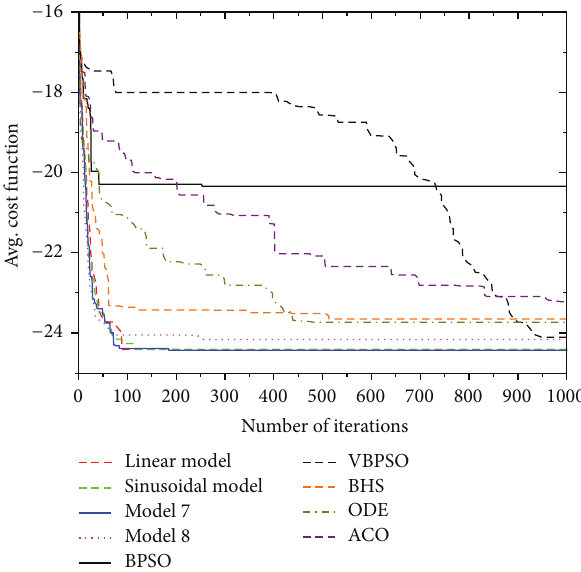
Figure 1: Convergence rate graph for the 300-element symmetric thinned array case.